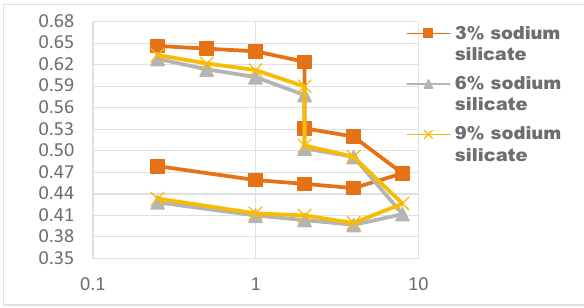
Figure 5: Collapse test results for soil treated with ( 3, 6, and 9% ) Sodium silicate solution.